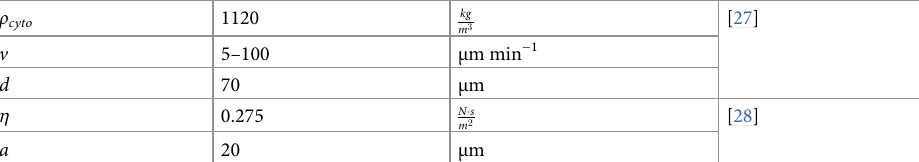
Table 1. Parameters used for the calculation of Re and α